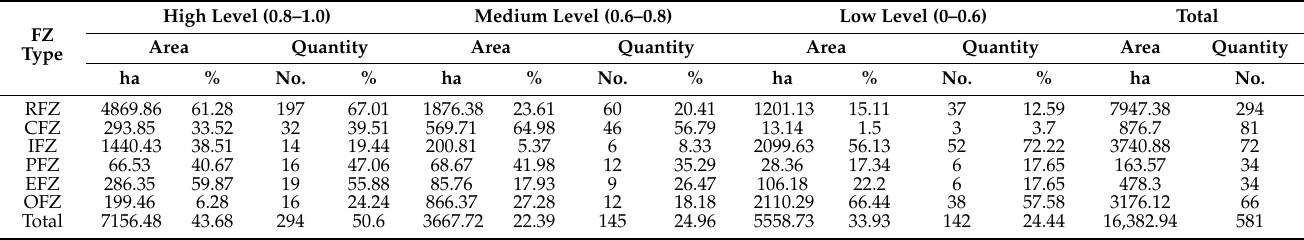
Figure 3. Evaluation results and spatial distribution of economic intensity of FZs. Table 3. Results of economic intensity in